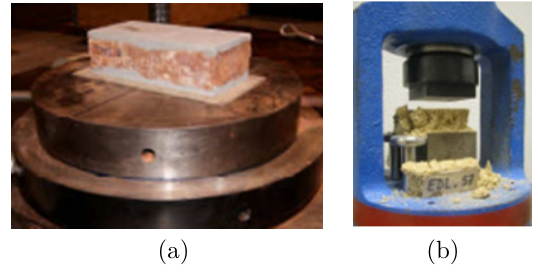
Figure 5. Axial compression tests: a) Solid clay bricks, b) Mortar [5].